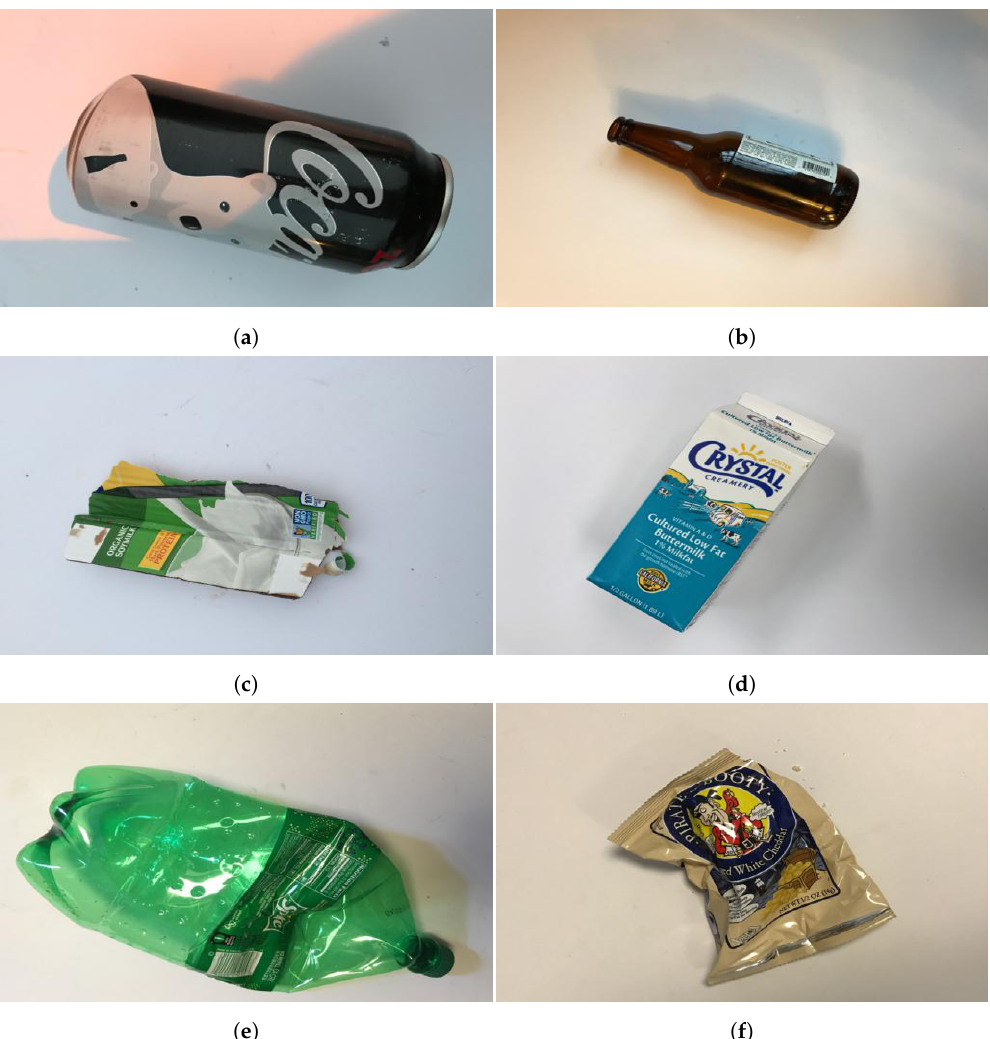
Figure 2. TrashNet dataset with one example of each class: ( a ) metal, ( b ) glass, ( c ) cardboard, ( d ) paper, ( e ) plastic, and ( f )